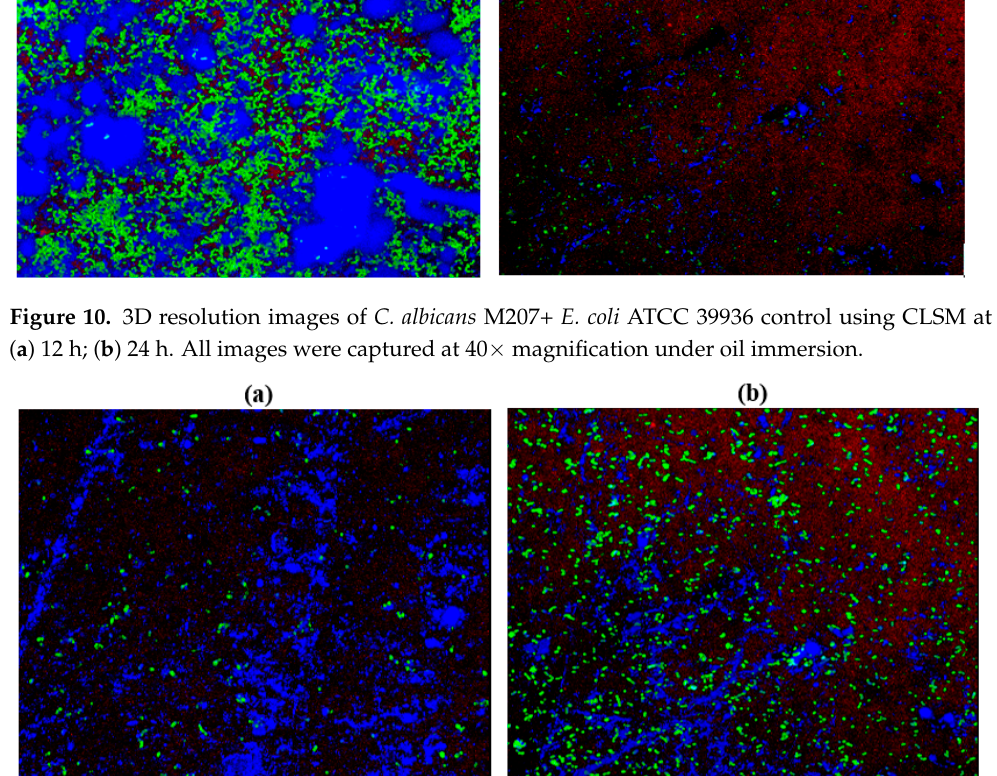
Figure 11. 3D resolution images of whole AGE ‐ treated (1.25 mg) C. albicans M207+ E. coli ATCC 39936 using CLSM at ( a ) 12 h; ( b ) 24 h. All images were captured at 40× magnification under oil